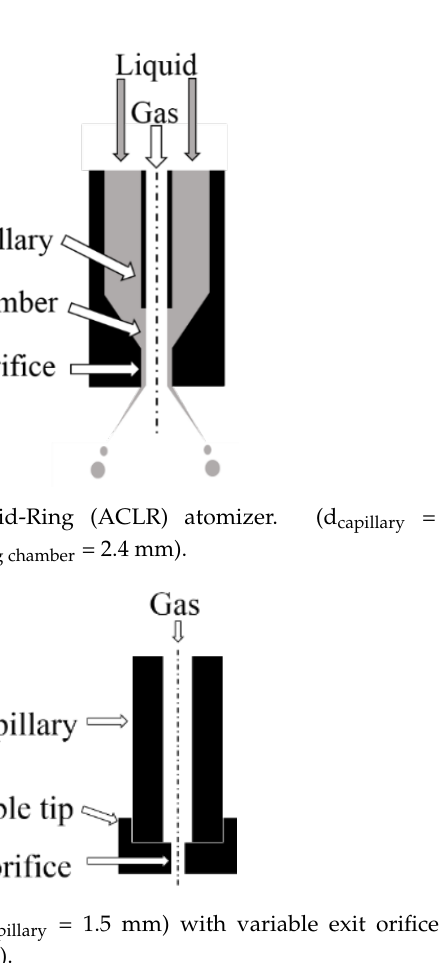
Figure 2. Scheme of the gas capillary (d capillary = 1.5 mm) with variable exit orifice diameter (d exit orifice = (d exit orifice = 1, 1.3, 1.5 mm; l exit orifice = 1.5 1, 1.3, 1.5 mm; l exit orifice = 1.5 mm).